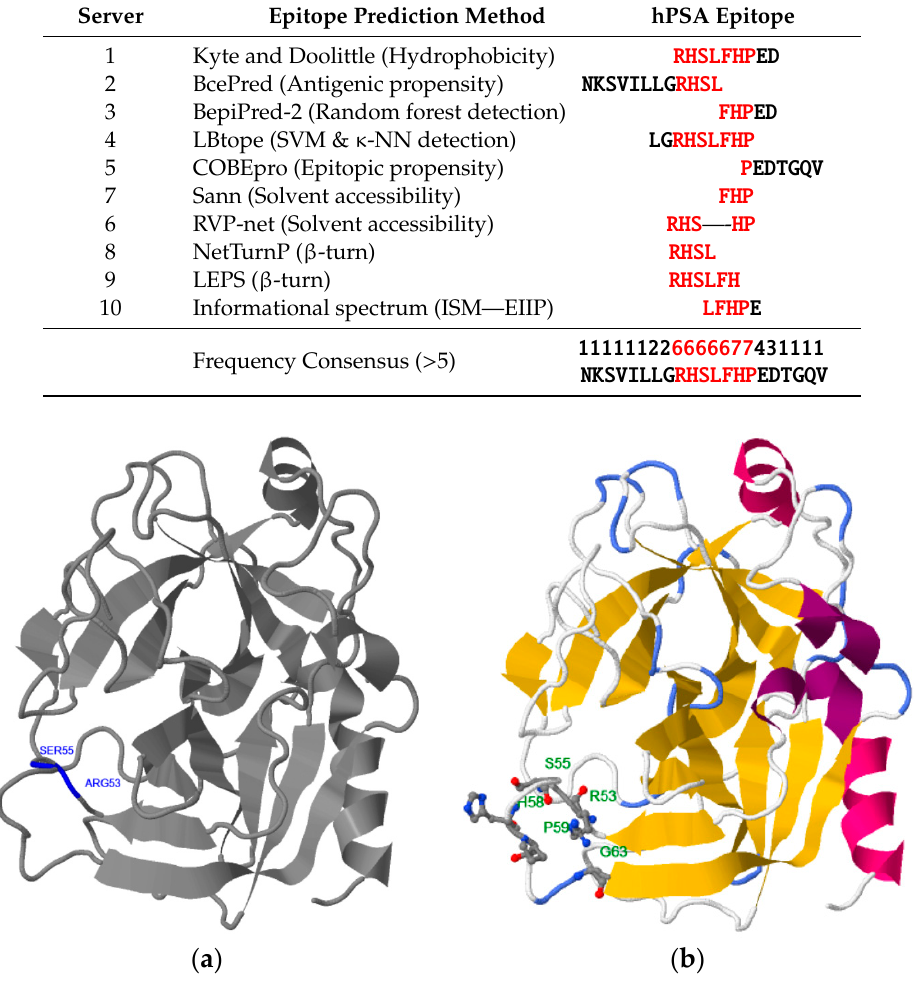
Figure 1. 3D structure and predicted binding site of hPSA: ( a ) Phyre2 server, and ( b ) RaptorX server. hPSA sequence and protein data bank (PDB) information are presented in Scheme S1 and Scheme S2, respectively.